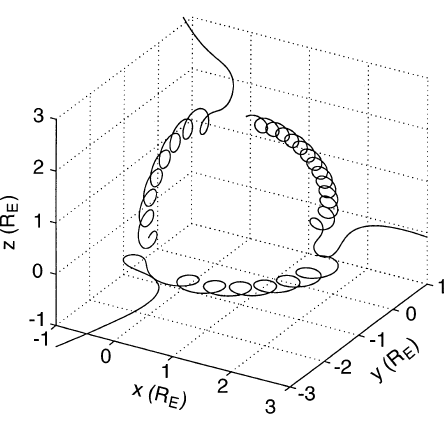
Fig. 5. Planar equatorial (50 keV) and meridional (5 keV) trajectories of a proton in an anti-symmetric sectorial octupole magnetic field ( m (cid:136) 2, n (cid:136) 3; g 32 (cid:136) 1246 nT, h 3 2 (cid:136) 293 nT)